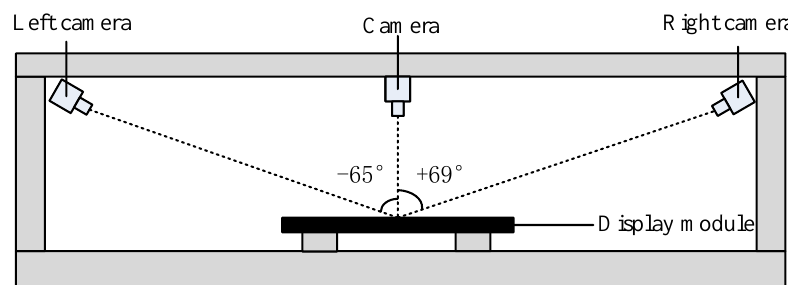
Figure 6. Experimental